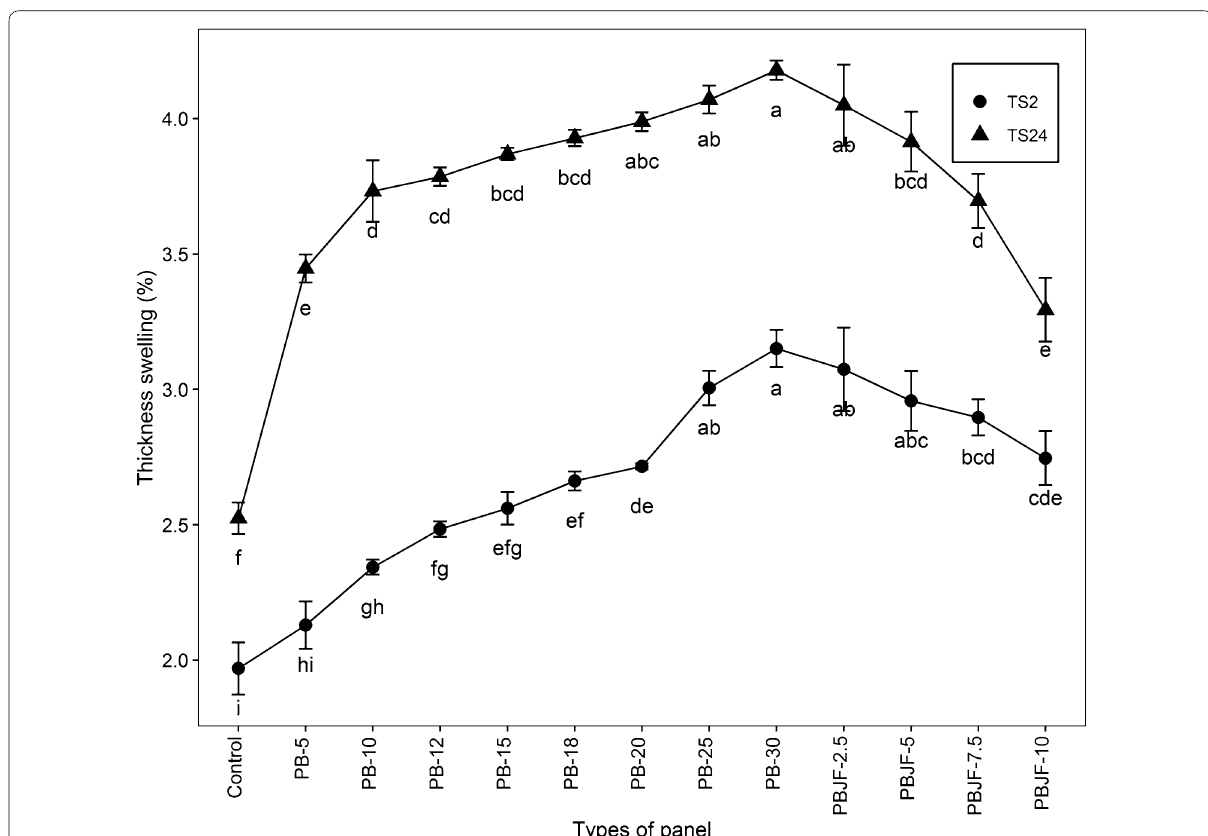
Fig. 3 Thickness swelling variation for different types of CBCs after 2 and 24 h of immersion in water. Different letters below each point indicate statistically significant differences among groups ( p <